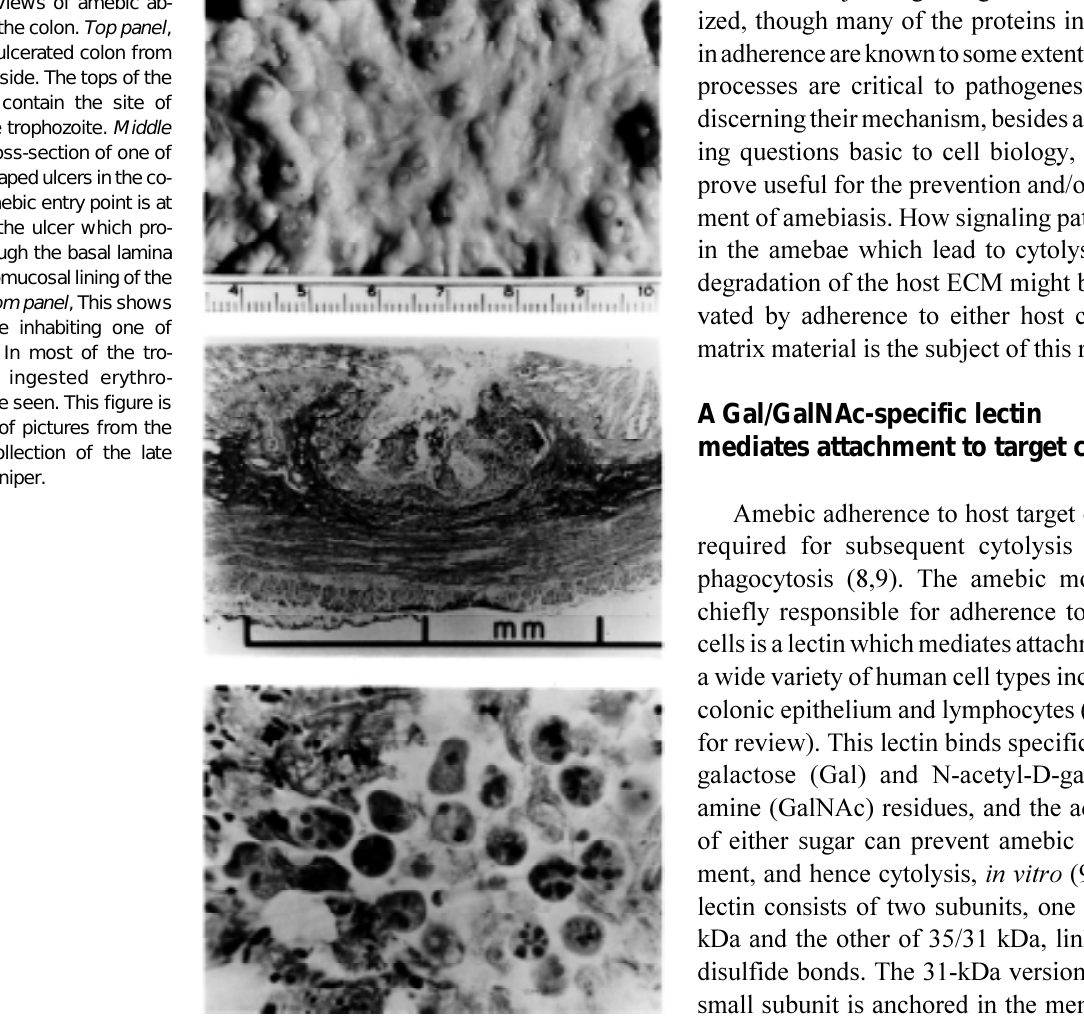
Figure 1 - Views of amebic ab- scesses of the colon. Top panel , Section of ulcerated colon from the luminal side. The tops of the abscesses contain the site of entry of the trophozoite. Middle panel , A cross-section of one of the flask-shaped ulcers in the co- lon. The amebic entry point is at the top of the ulcer which pro- trudes through the basal lamina into the submucosal lining of the colon. Bottom panel , This shows the amebae inhabiting one of the ulcers. In most of the tro- phozoites, ingested erythro- cytes can be seen. This figure is composed of pictures from the personal collection of the late Harrison